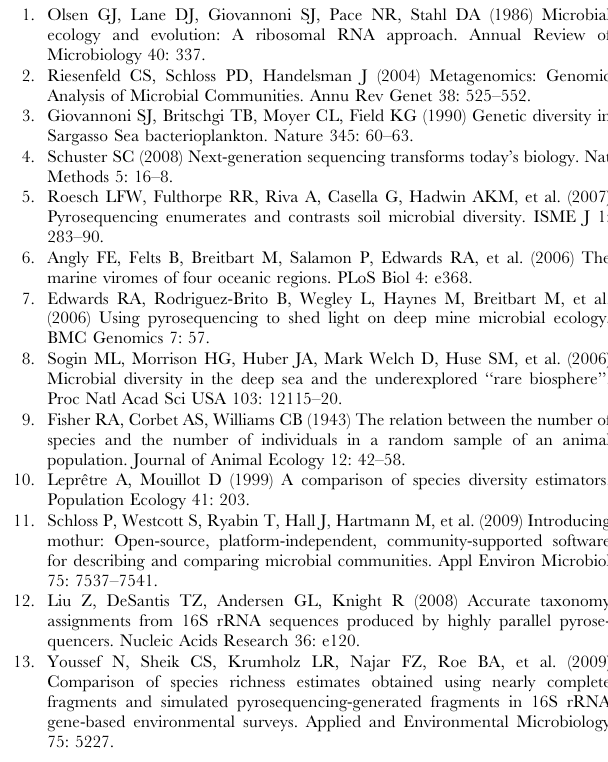
Figure S2 Snippets of 9 reads aligned using the 4 different methods described in this paper. The 9 reads are of the V3 region of the 16S rRNA. ( a ) Sequences aligned via RDP [30] which uses the Infernal aligner [33]. Note that the hypervariable region is left unaligned (bases 36 through 64). ( b ) Sequences aligned via NAST [29] (as implemented by Mothur [11]) to the SILVA [32] database. Notice the inconsistencies in the alignment of the regions with strong secondary structure conservation (bases 5, 25, 29, 72 through 79, and 85). ( c ) Sequences aligned using the merge program in the tool we developed, TORNADO (http://tornado.igb.uiuc.edu). The merge process takes the unaligned, hypervariable parts of the sequence aligned by (a) and replaces them by the alignment in (b). Figure S3 Illustration of the process of the complete linkage algorithm. Smaller clusters are progressively merged into larger ones as long as no two elements of a cluster are farther than r from each other. Figure S4 Sketch of the calculation of the number of clades with uniform OTUs. A phylogenetic tree with 2 different cluster (OTU) assignments is shown. The cluster assignment is indicated by OTU number and color. Both cluster assignments have 2 uniform clades (interior nodes indicated by